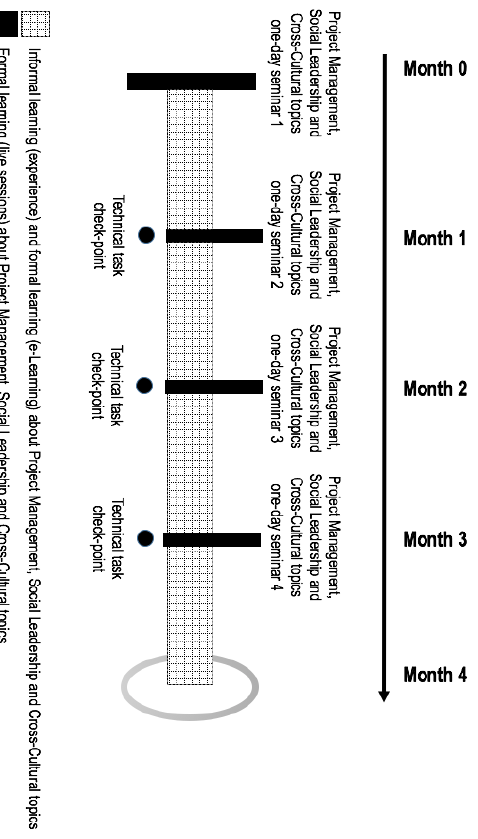
Figure 2. A Blended Learning Approach for effective virtual